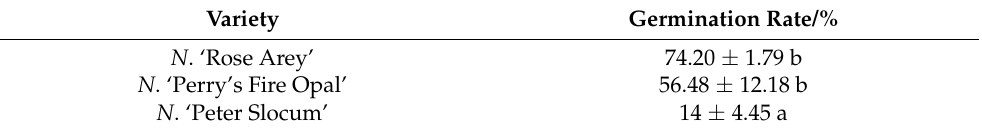
Figure 3. Pollen germination of three hardy water lily varieties on solidified medium. ( a ) N. ‘Rose Arey’; ( b ) N. ‘Perry’s Fire Opal’; ( c ) N. ‘Peter Slocum’. Optical microscope, bar = 50 µ m. Table 4. Pollen germination rate of three hardy water